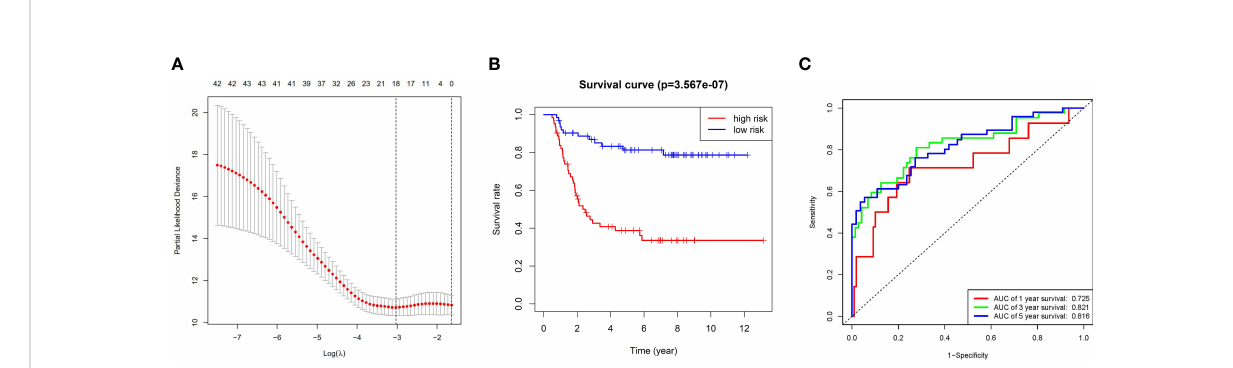
FIGURE 6 Construction of gene prognostic models and their prognostic characteristics. (A) Eighteen genes were used to construct the risk models. Coef fi cients were calculated from univariate Cox regression analysis using LASSO. (B) Survival analysis was performed using the Kaplan ‐ Meier method for the overall survival of patients in TARGET. (C) The predictive ef fi ciency of the gene prognostic model showed by ROC curves based on 1-, 3 ‐ and 5 ‐ year survival